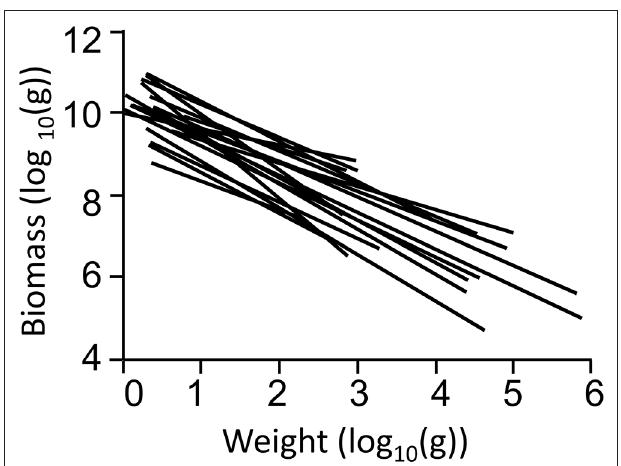
FIGURE 3 | Particle size distribution (PSD) spectra for 19 models in China’s coastal ecosystems.